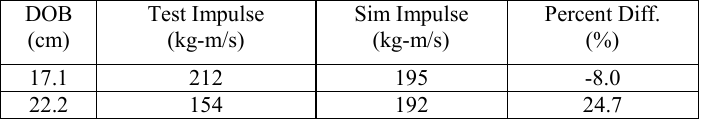
Table 2. CTH Results Summary